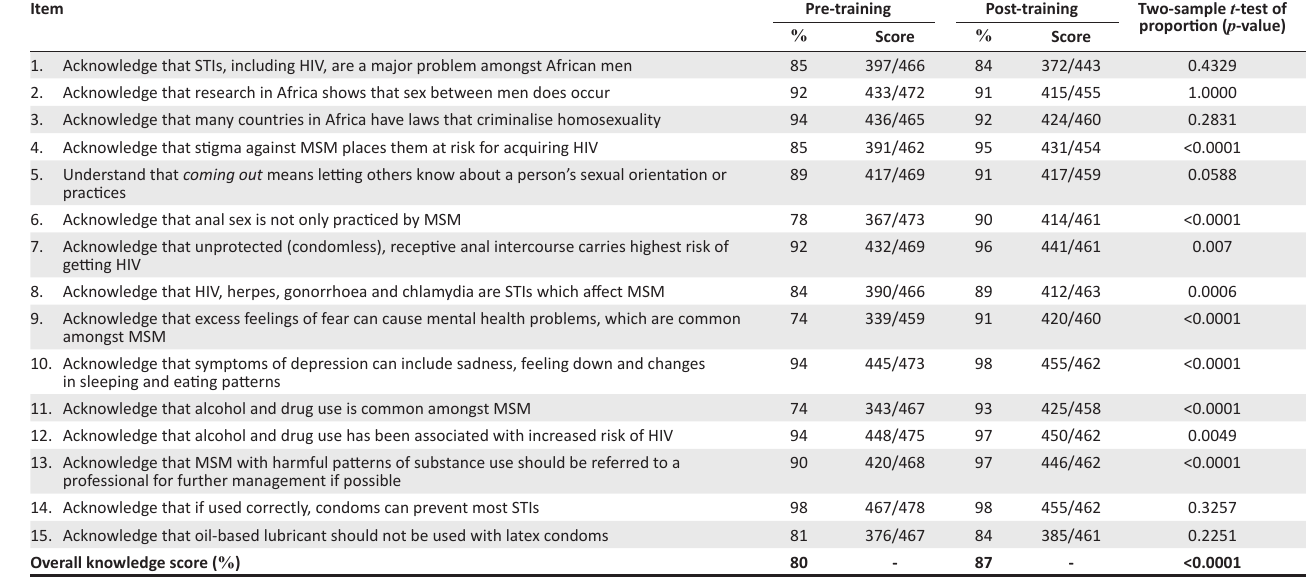
TABLE 1: Comparison of pre–post training knowledge